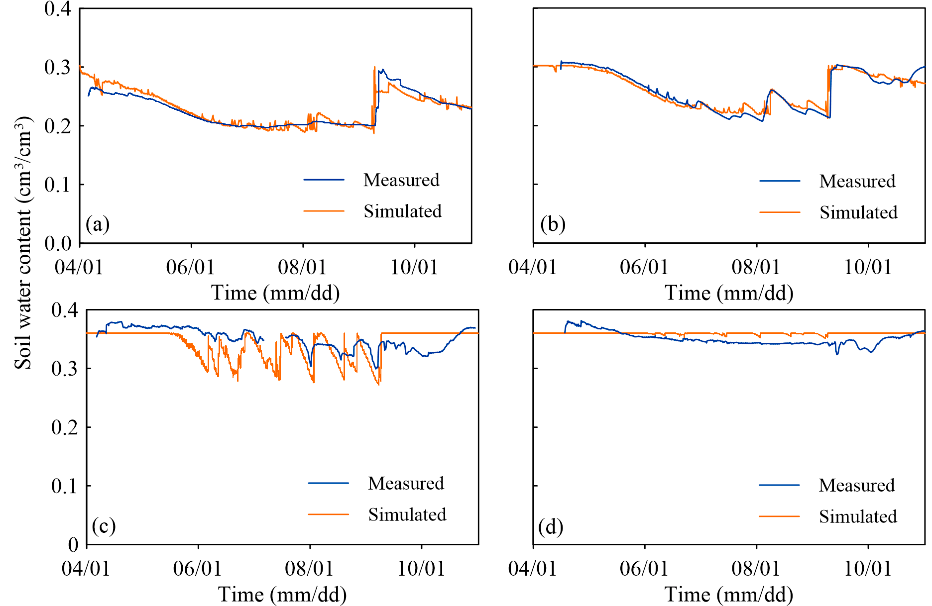
Figure 4. The measured and simulated data of soil moisture at ( a ) 60 cm depth and ( b ) 80 cm depth for K1, and ( c ) 50 cm depth and ( d ) 70 cm depth for K14. Table 4. The root mean square error (RMSE), Nash-Sutcliffe efficiency (NSE), percent bias (PBIAS) and R-square (R 2 ) of the measured and simulated soil moisture for K1 and K14. RMSE (cm 3 /cm 3 )